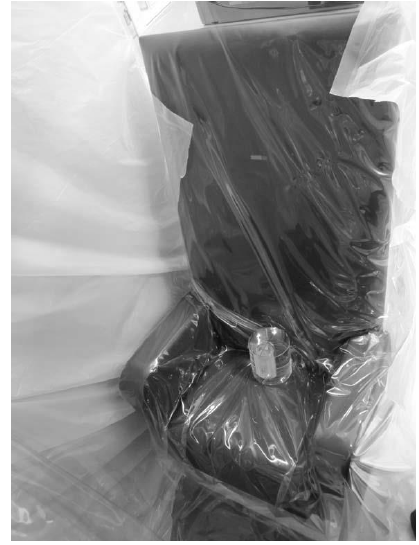
Figure 3. Substitute bladder phantom.